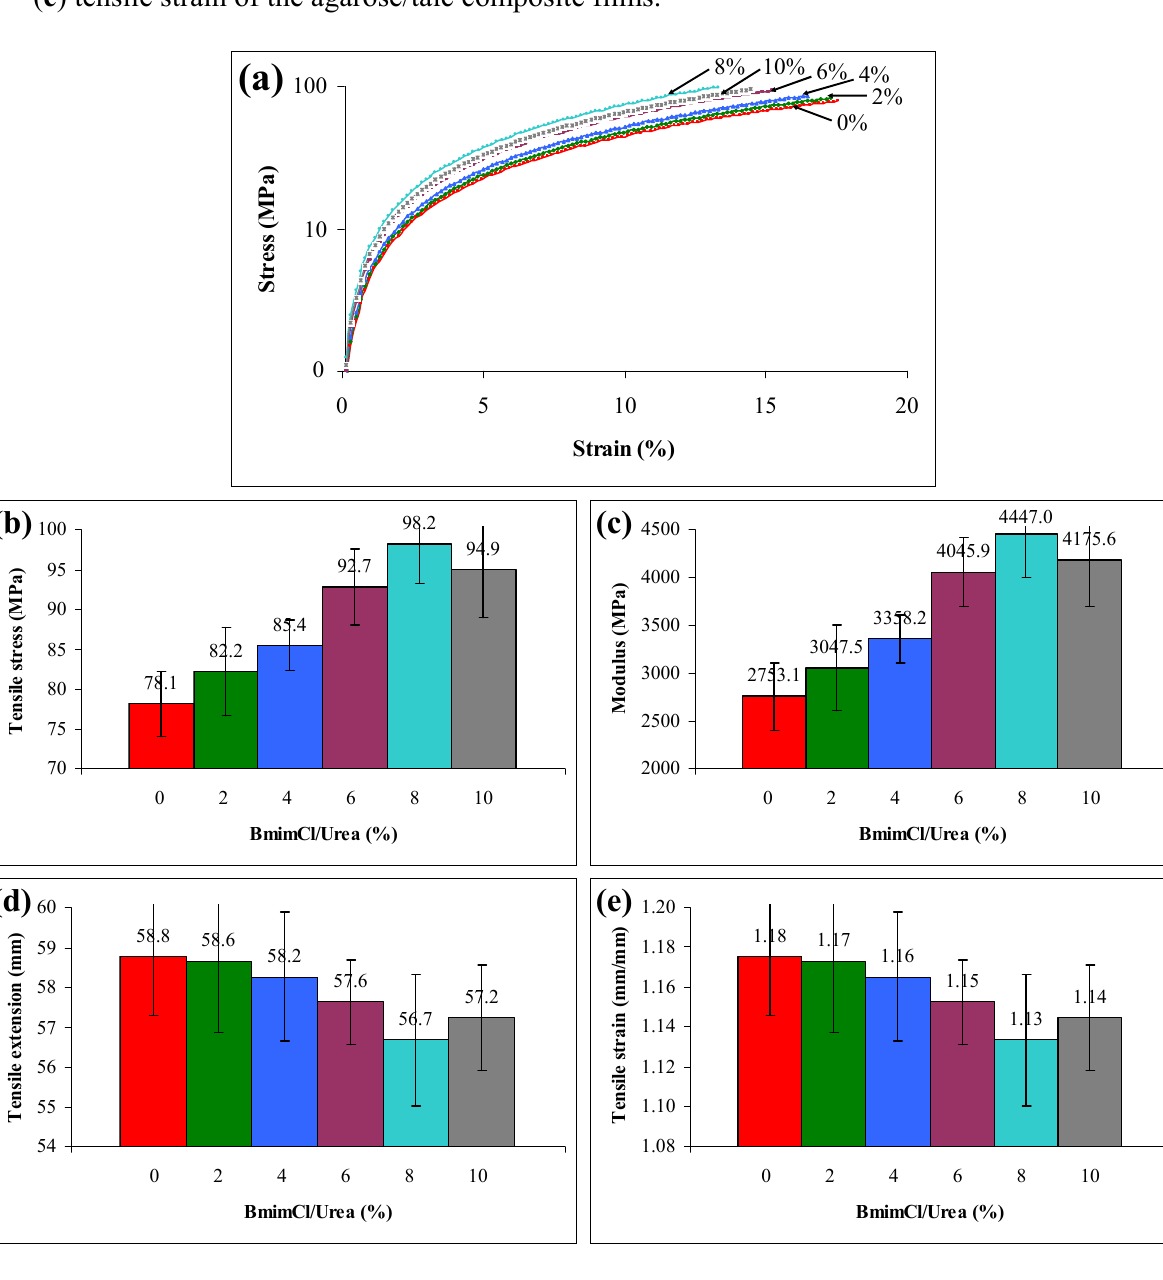
Figure 1. Effects of 1-n-butyl-3-methylimidazolium chloride (BmimCl) content on ( a ) stress-strain behaviour; ( b ) tensile stress; ( c ) modulus; ( d ) tensile extension and ( e ) tensile strain of the agarose/talc composite